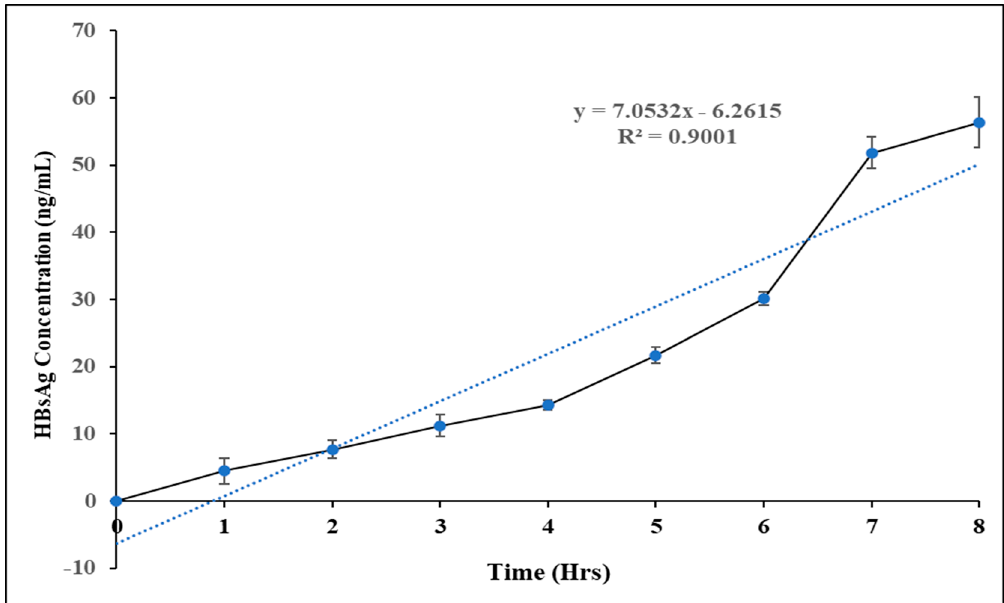
Figure 6. In vitro release profile of HBsAg from lyophilized recombinant HBsAg–loaded docosahex- aenoic acid nanovesicles .